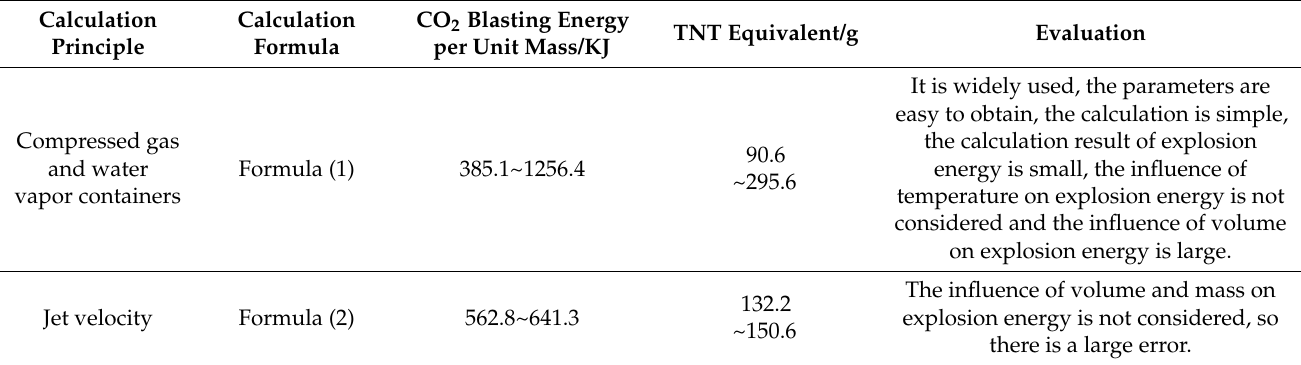
Table 1. Calculation method of CDPTB